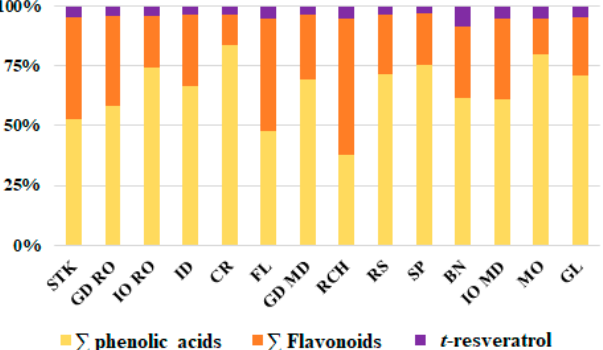
Figure 1. Ultra-high performance liquid chromatography (UHPLC) polyphenolic profile (phenolic acids, flavonoids and t-resveratrol) of different apple cultivars: STK-Starkrimson, GD RO-Golden Delicious from Romania, IO RO-Jonathan from Romania, ID-Idared, CR-Cretesc, FL-Florina, GD MD-Golden Delicious from Republic of Moldova, RCH-Richard, RS-Renet Simirenco, SP-Spartan, BN-Beliy Naliv, IO MD-Jonathan from Republic of Moldova, MO-Montuan, GL-Gloster. The values of the TP obtained by the Folin Ciocalteu colorimetric method ranged from 240–576 mg GAE/100 g DW, while TF ranged between 65–166 mg RE/100 g DW (Figure S1). Starkrimson, Richard and Idared were the apple cultivars with a high TP content, while Montuan, Jonathan and Spartan were the apple cultivars with high TF content. TP content of different apple cultivars harvested in Italy varied from 156 to 535 mg GAE/100 g peel (DW) and from 46 to 175 mg GAE/100 g pulp (DW) [27], while TF content of differ- ent apple cultivars harvested in Korea varied from 104 to 192 mg QE/100 g of peel (DW) and from 1.5 to 3.2 mg QE/100 g of pulp (DW), respectively [31]. The results of the AC of all the investigated apple cultivars measured by DPPH assay demonstrated a large variability, ranging from 1277 to 2794 μ mol Trolox/100 g DW. Ex- tracts from Starkrimson, Jonathan, Richard and Beliy Naliv cultivars showed the highest AC, whereas the Gloster, Montuan, Golden Delicious and Spartan revealed the lowest AC. The values of AC of the peel and pulp (DW) of different apple cultivars harvested in Ko- rea, measured by DPPH assay, varied between 280–500 μ mol Trolox equivalents/100 g of peel (DW) and between 12–348 μ mol Trolox equivalents/100 g of pulp (DW) [32]. Thus, the cultivars that can be highlighted by their high content of polyphenols, being a good source of polyphenols, are Starkrimson, Jonathan, Richard and Beliy Naliv. The results of TP and TF obtained by colorimetric methods were higher compared with UHPLC quantification results, being in concordance with the findings of [30], indi- cating that there are more phenolic compounds, including phloretin, phloridzin, poly- meric procyanidins (procyanidin B1, procyanidin B2), quercetin-glycosides [33,34] and others, which contributed to the total polyphenolic content and which were not quantified in this study because we did not have the necessary standards. The ANOVA results applied to the spectrophotometric results indicate that the TP, total TF and AC were significantly different depending on the apple cultivars (Figure S1). Higher TP content was identified for Starkrimson, Richard and Idared cultivars, and higher TF content for Beliy Naliv and Montuan cultivars. The correlation analysis (Table 3) shows low to moderate correlations between the UHPLC phenolic compounds profile (expressed as ∑ phenolic acids and ∑ flavonoids )